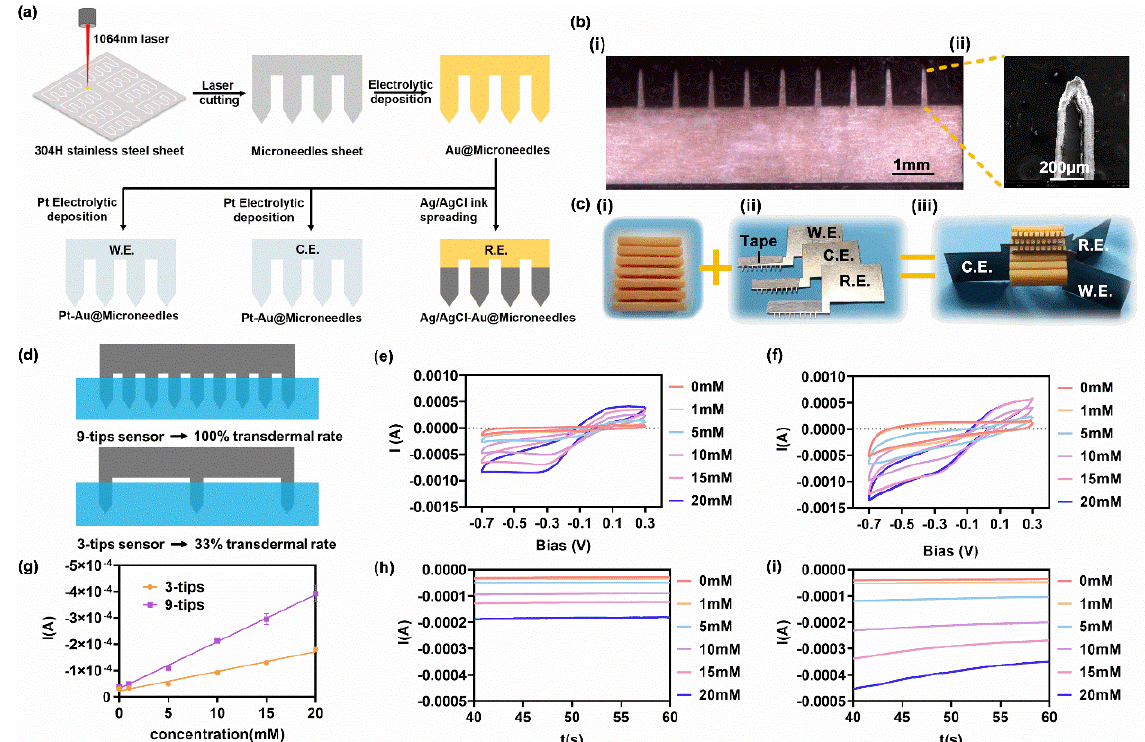
Figure 2. Fabrication of the metallic sheet microneedle array sensors and their sensing performance. ( a ) Fabrication of three − electrode metallic microneedle sheet. ( b ) (i) Optical micrograph of the microneedle sheet. (ii) SEM of the Pt/Au coated microneedle. ( c ) (i) Photograph of red resin frame case. (ii) Photograph of the metallic microneedle sheet with the tape sticking to the back. (iii) Photograph of the assembled sensor. ( d ) Schematic diagram of the H 2 O 2 sensing experiment. ( e , f ) Scanning results of the three − tip sensor ( e ) and nine − tips sensor ( f ) in gradient H 2 O 2 solution (0, 1, 5, 10, and 20 mM) by cyclic voltammetry ( − 0.7 to 0.3 V). ( g ) Steady − state amperometric responses (t > 40 s) were analyzed, and relations with H 2 O 2 concentration were linearly fitted. ( h , i ) Respective amperometric responses of three-tip sensor ( h ) and nine-tip sensor ( i ) soaked in gradient H 2 O 2 solutions. Bias = −0.3 V.